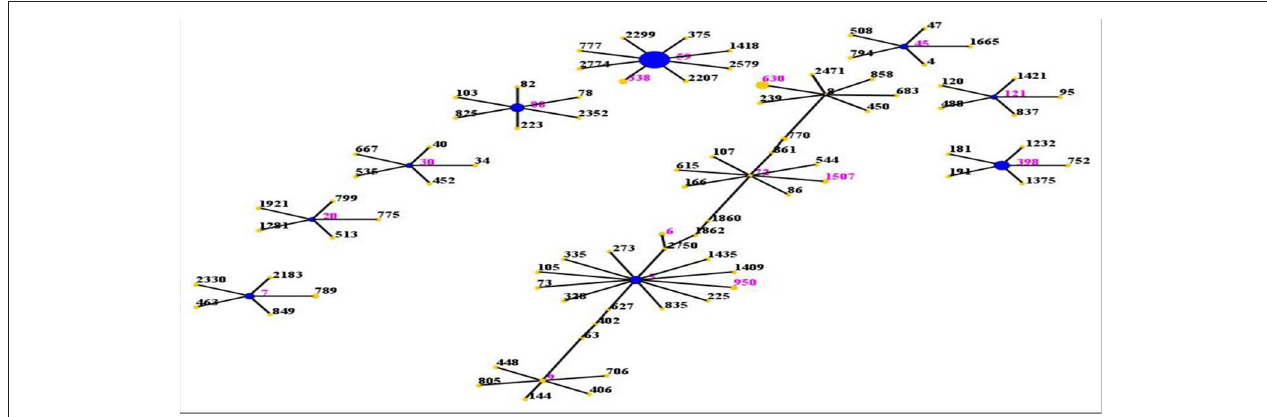
FIGURE 1 | Distribution of STs in the clonal complexes. The eBURST application of the MLST data from all of the isolates analyzed in this study. The purple numbers represent 16 STs which are found in 80 MRSA isolates. STs that are linked by a line belong to the same cluster. Circle sizes are proportional to the number of strains within the